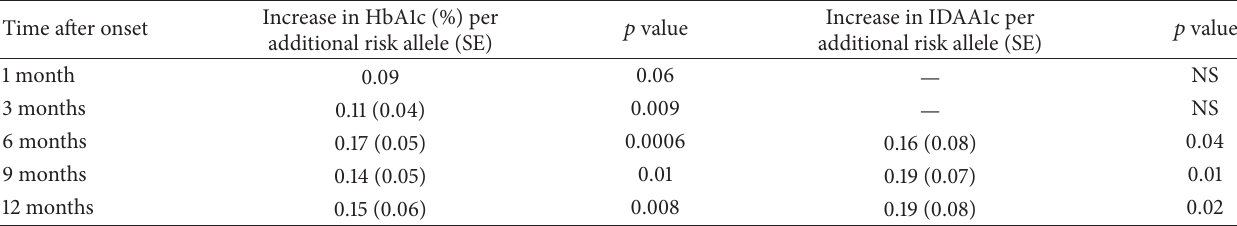
Table 2: Impact on HbA1c and IDAA1c by increasing genetic risk